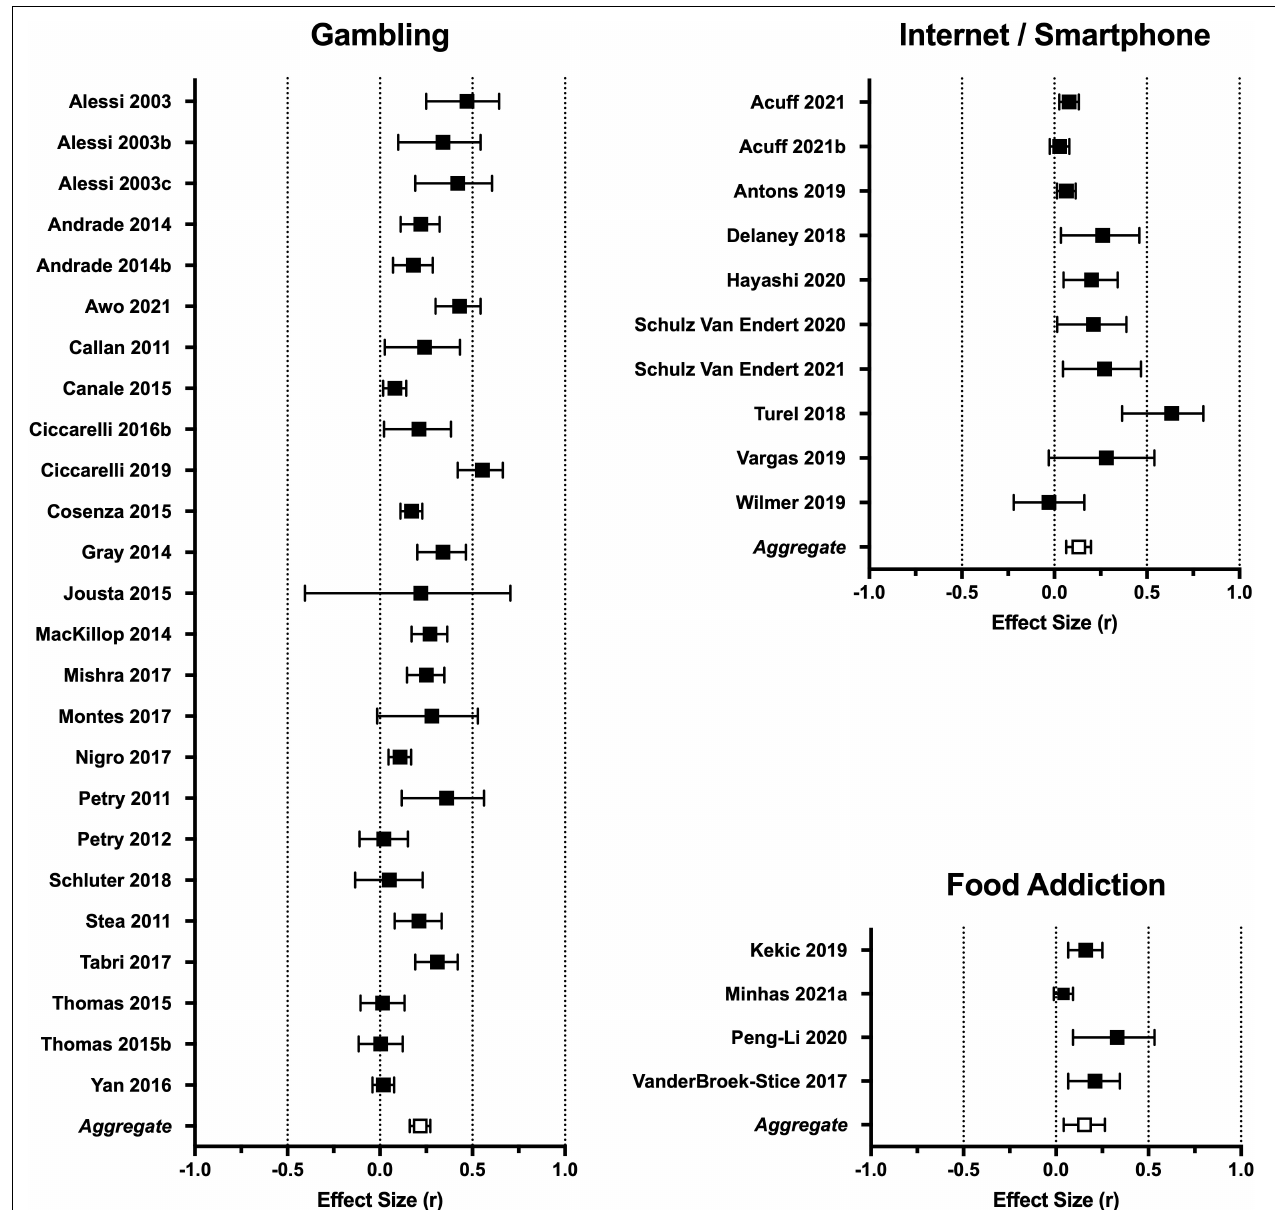
FIGURE 3 | Forest plots depicting effect sizes for dimensional studies. Individual data points reflect effect size (Pearson’s r) and 95% confidence intervals. The aggregate effect size generated by the random-effects model is provided at the bottom of each forest plot. Complete data is provided in Supplementary Table 3